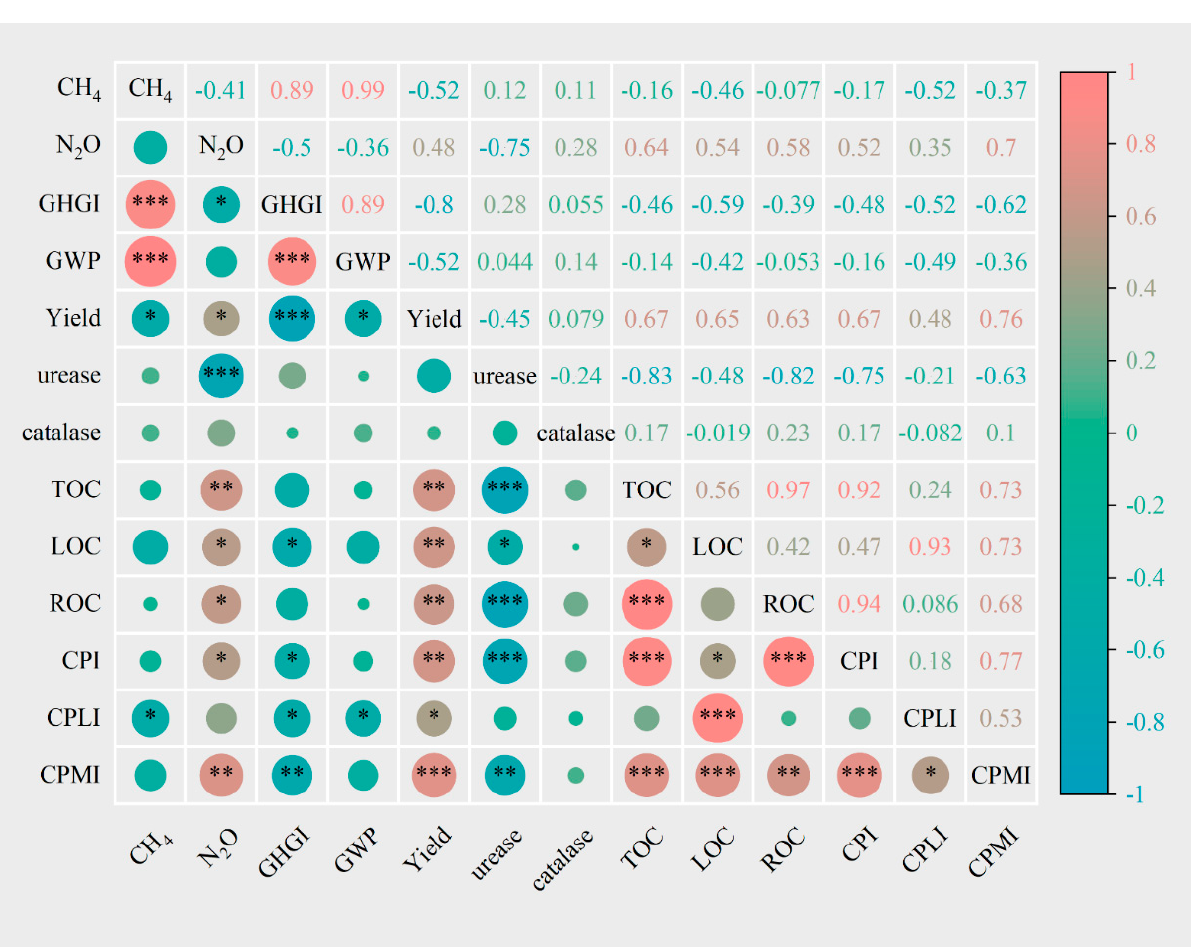
Figure 6. Correlation analysis between different indicators. *, significant at the 0.05 probability level; **, significant at the 0.01 probability level; ***, significant at the 0.001 probability level, according to the LSD test. Different numbers represent correlation coefficients. GWP , global warming potential.